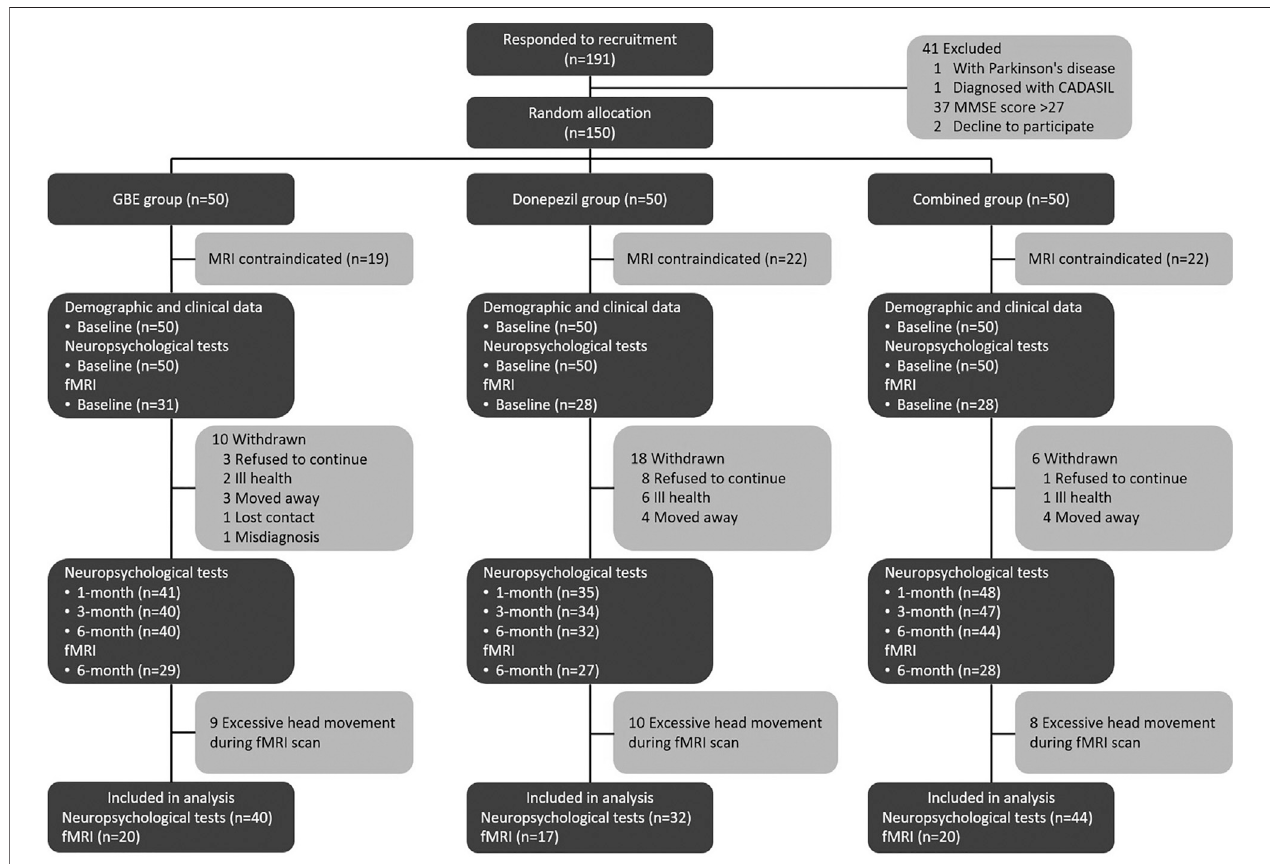
FIGURE 1 | Study logistics of recruitment, assignment, intervention, and assessment. CADASIL: cerebral autosomal dominant with subcortical infarcts and leukoencephalopathy;MMSE:minimummentalstateexamination; GBE:Ginkgobilobaextract;MRI:magneticresonanceimaging;fMRI:functionalmagneticresonance